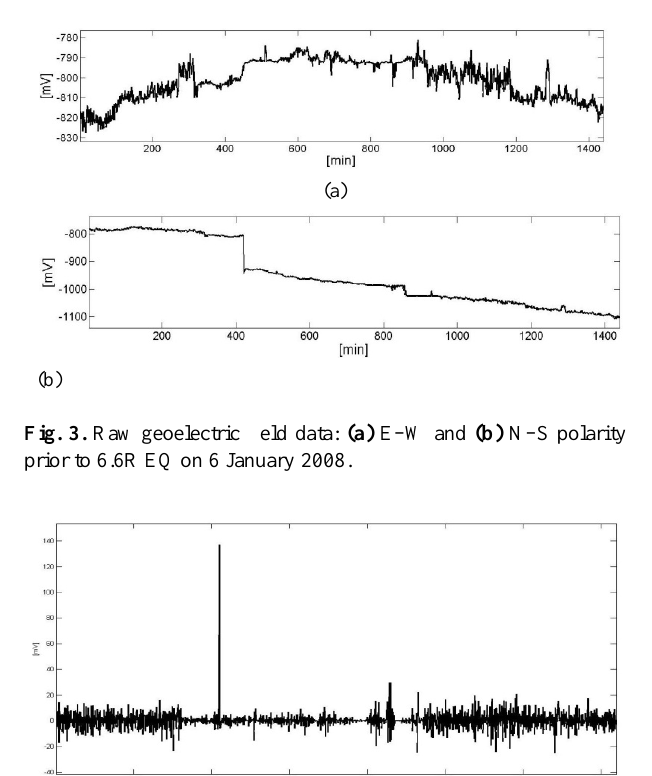
Figure 2. Flowchart of the proposed feature extraction technique.15